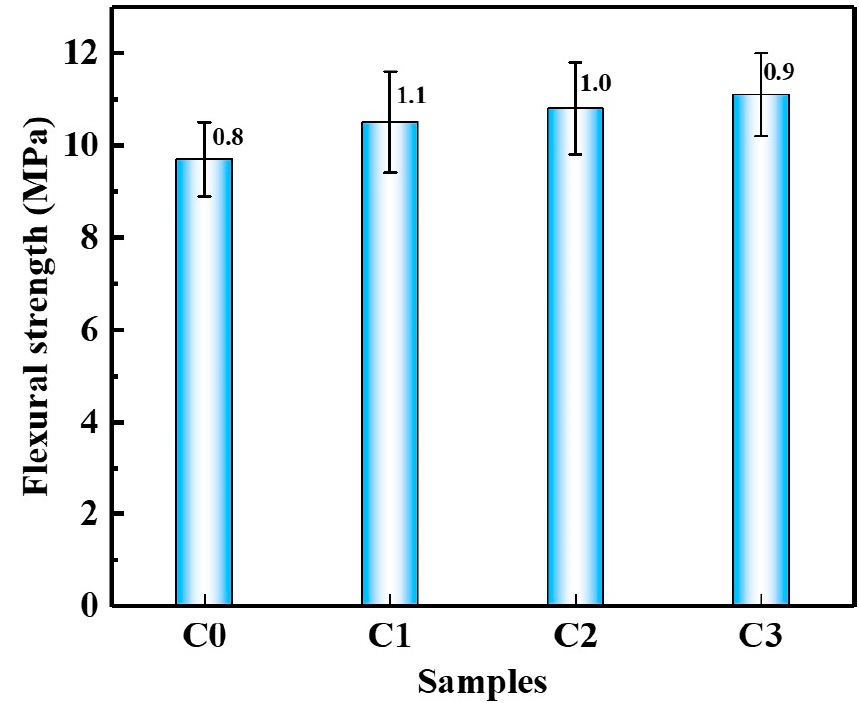
Figure 4. Flexural strength of SAC paste.